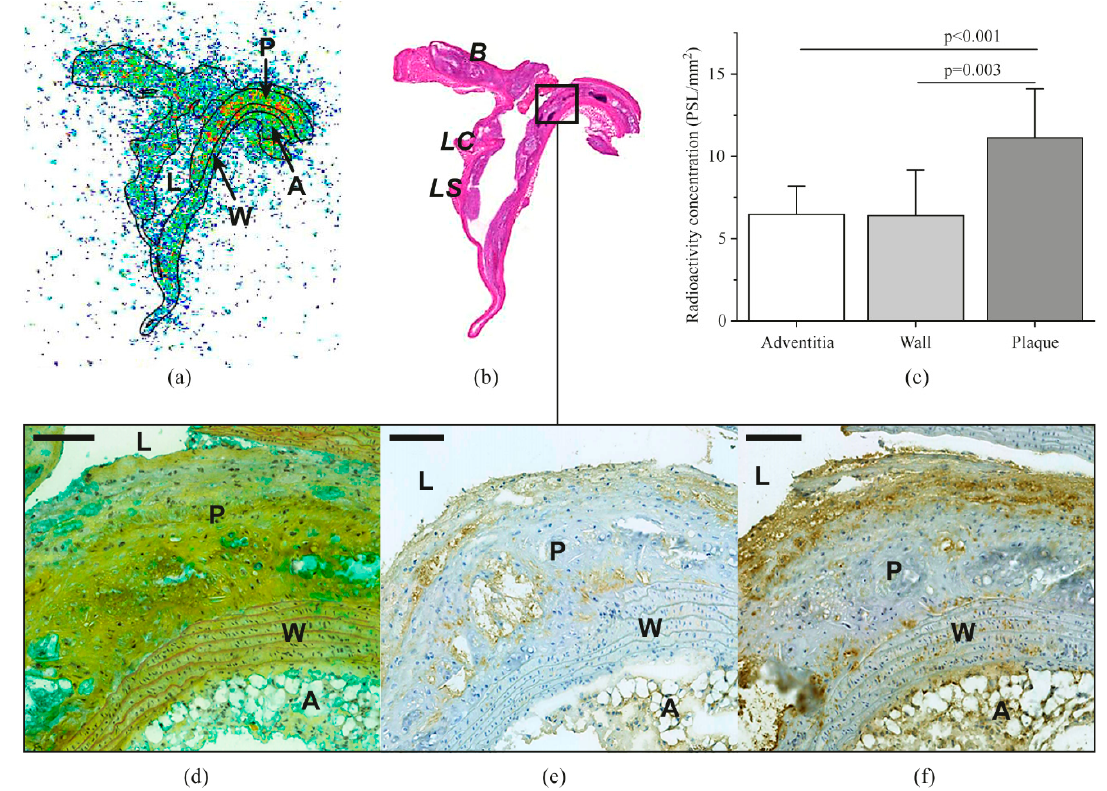
Figure 2. Distribution of [ 68 Ga]Ga-DOTA-TCTP-1 in atherosclerotic mouse aorta as detected by digital autoradiography ( a ), and compared to anatomic landmarks after H&E staining ( b ). Panel ( c ) shows average tracer accumulation in the adventitia, normal vessel wall (wall), and atherosclerotic plaques (plaque). Micrographs show adjacent sections of an atherosclerotic plaque stained with